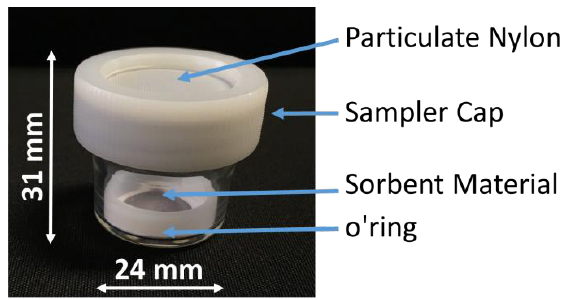
Figure 10. Prototype of mercury passive sampler comprising a diffusive membrane (particulate filter), the fibrous disc coated with AuNP/TiO 2 NP (sorbent material), and a borosilicate vessel allowing the axial diffusion of Hg 0 from the cap to the bottom. The O-ring stops the disk on the tube bottom.